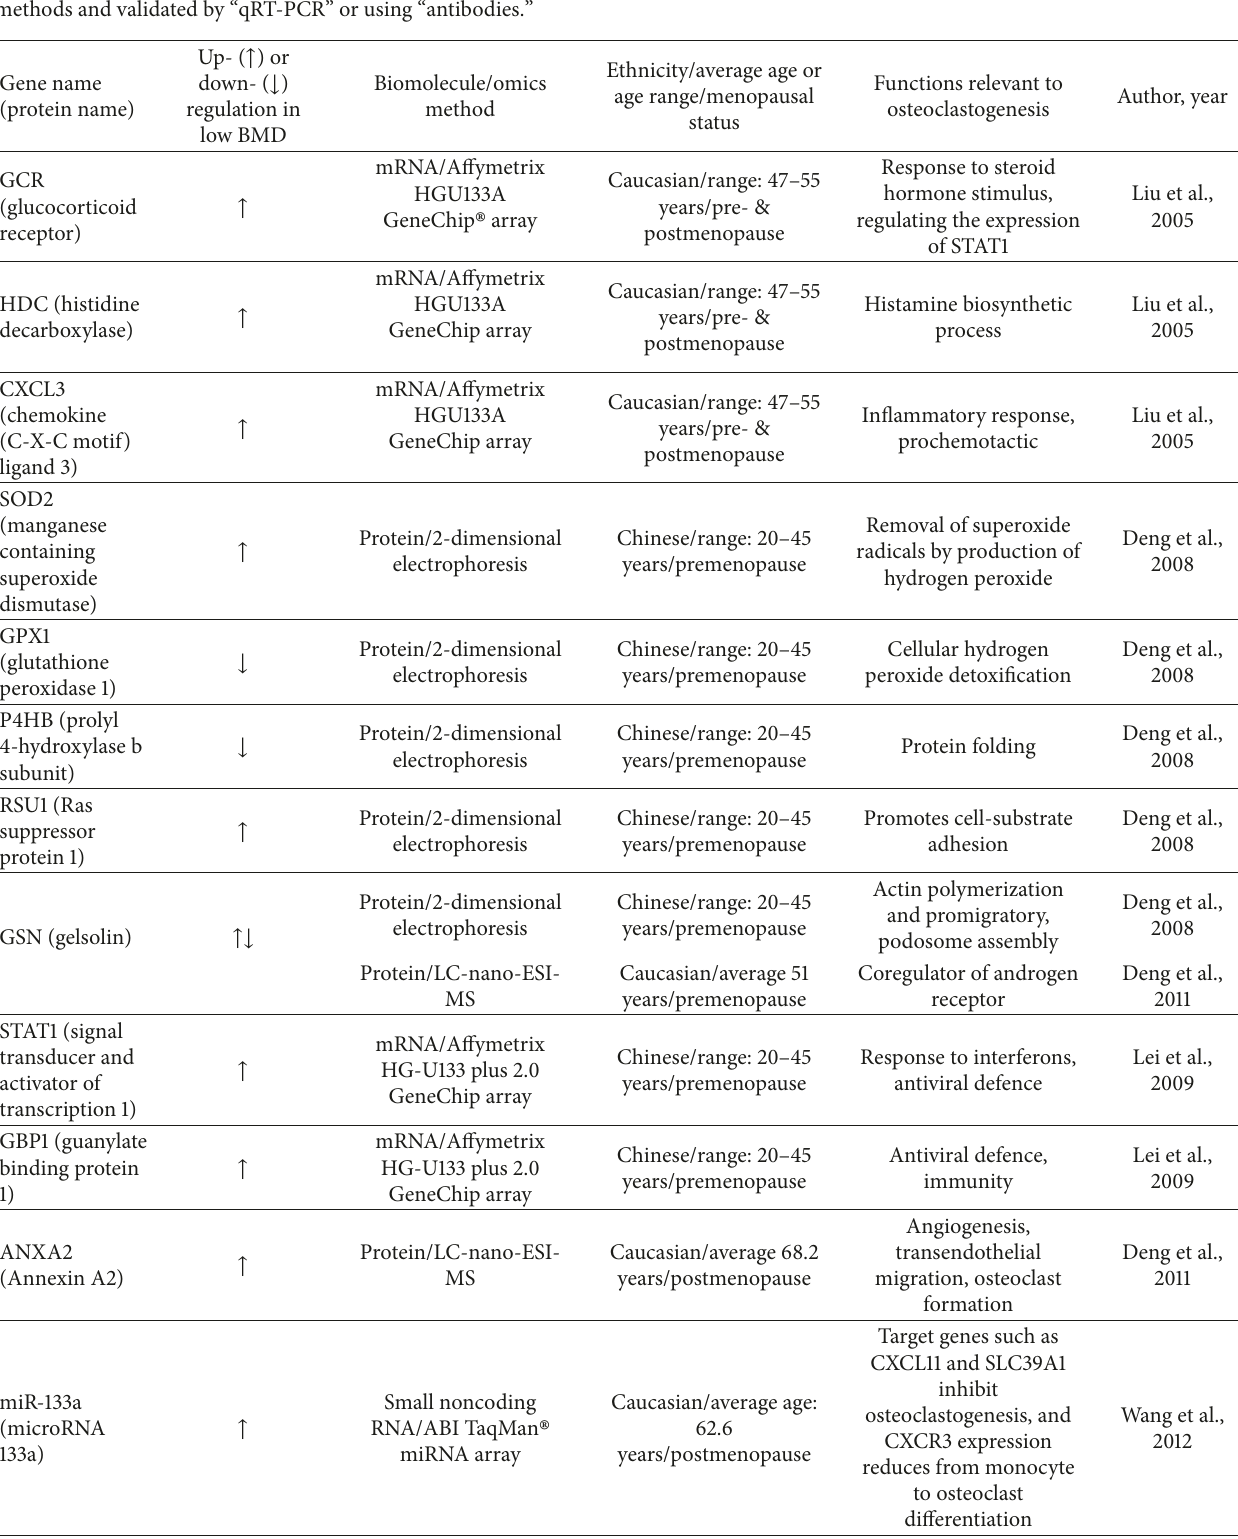
Table 1: List of differentially expressed biomolecules in low versus high bone mineral density (BMD) condition identified using “omics” methods and validated by “qRT-PCR” or using